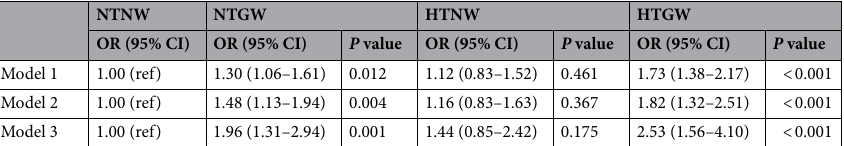
Table 2. Associations between triglyceridemic-waist phenotypes and incident chronic kidney disease. NTNW normal triglyceride levels and normal waist circumference, NTGW normal triglyceride levels with enlarged waist circumference, HTNW high triglyceride levels and normal waist circumference, HTGW high triglyceride levels and enlarged waist circumference, OR odds ratio, CI confidence interval. Model 1 only included the triglyceridemic-waist phenotypes without adjustment for any covariate. Model 2 adjusted for baseline age, sex, residence, education level, smoking and drinking status, BMI, HDL-c, history of DM, hypertension, and CVD, use of hypoglycemic agents, anti-hypertensive agents, and lipid-regulating agents, as well as baseline eGFR levels. Model 3 additionally adjusted for physical activity, with only 3,100 participants having available data.